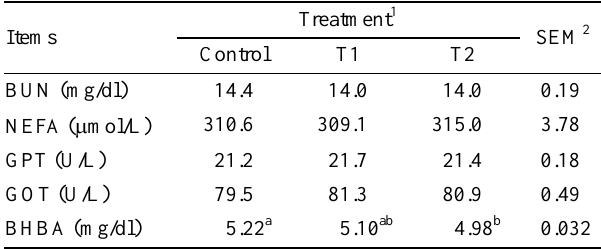
Table 3. Effect of HMBi supplementation on plasma metabolites